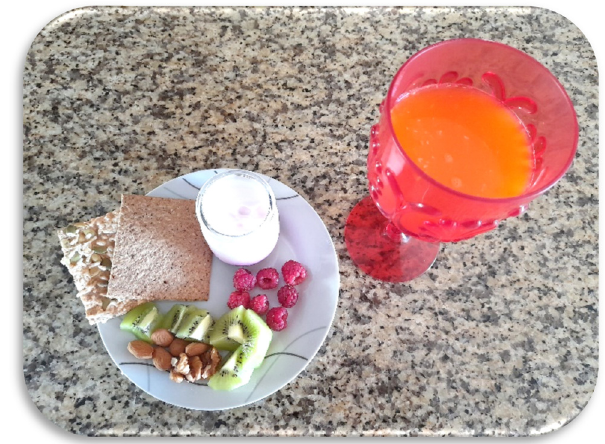
Figure 7: Example of foods/beverages present in a continental